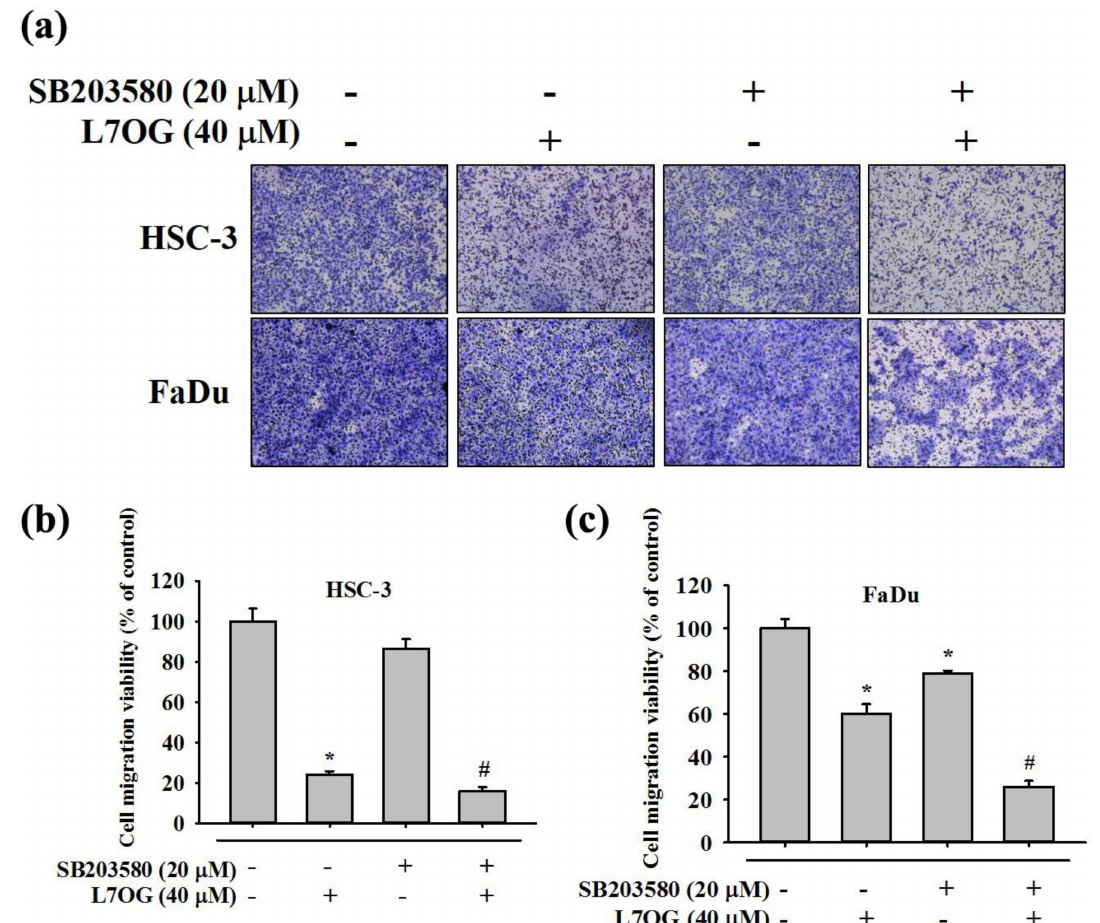
Figure 8. E ff ect of SB203580 and luteolin-7-O-glucoside co-treatment on cell migration in HSC-3 and FaDu cell lines. The cell migration ( a ) was measured using trans-well assay after the co-treatment with SB203580 and luteolin-7-O-glucosidein HSC-3 and FaDu cell lines. The quantitative results are shown for ( b ) HSC-3 and ( c ) FaDu cells. The values are represented as mean ± SD of at least three independent experiments. * p < 0.05, compared to the control group; # p < 0.05, compared to the luteolin-7-O-glucoside treated